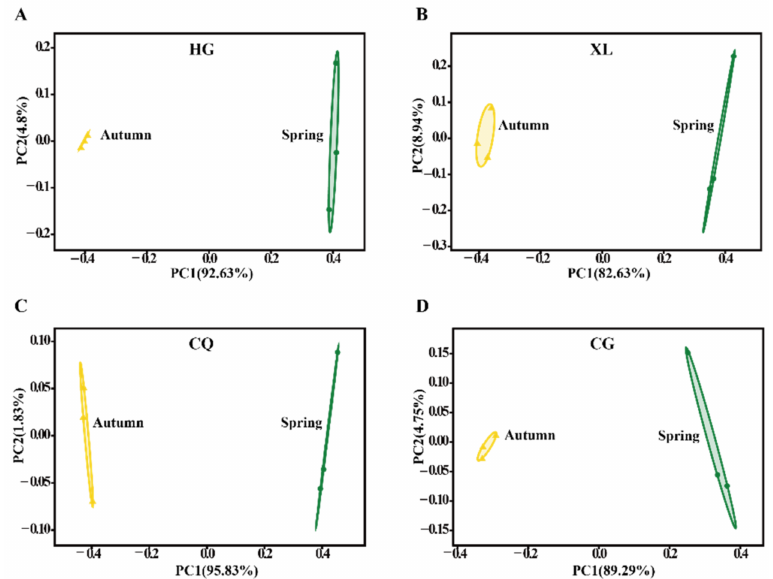
Figure 3. PCoA analysis based on Bray Curtis index of spring and autumn samples from each cultivar. HG ( A ), XL ( B ), CQ ( C ), and CG ( D ) represent fungal communities from “Hong Guo No.2”, “Xin samples are represented by green dots and autumn samples by yellow triangles.